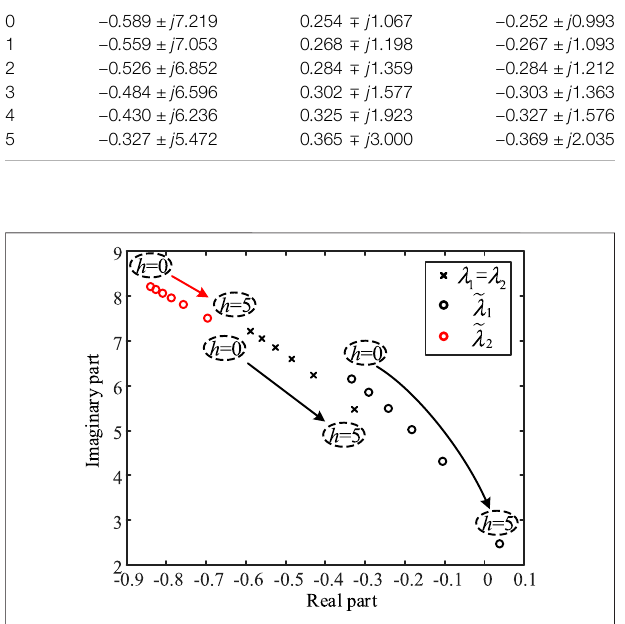
FIGURE 11 | Trajectories of the open and closed-loop mode when Z 3 increases.